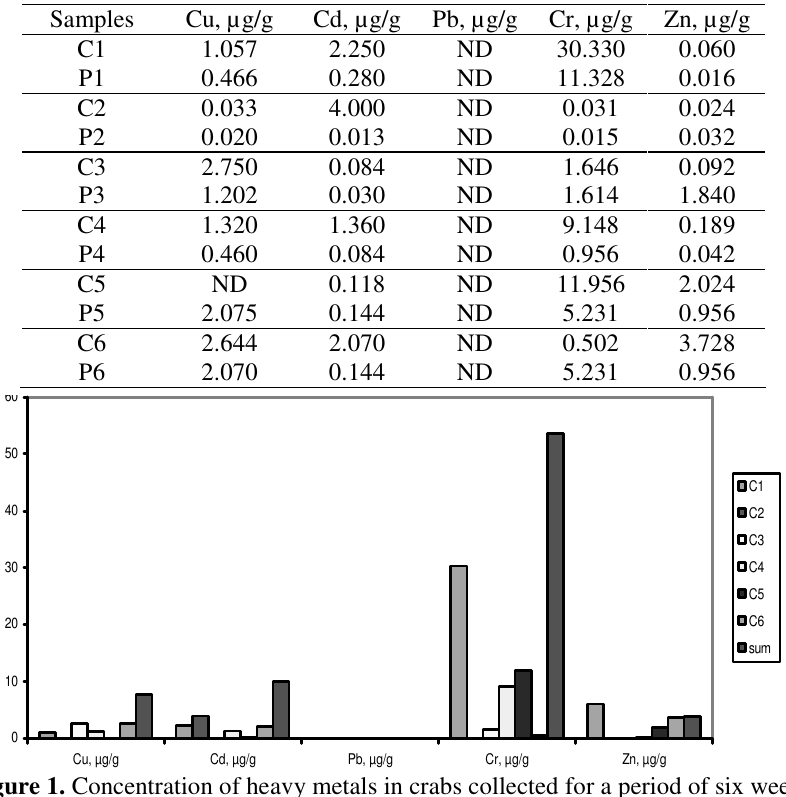
Table 3. Comparison of heavy metals content of crab and prawn collected at same periods.